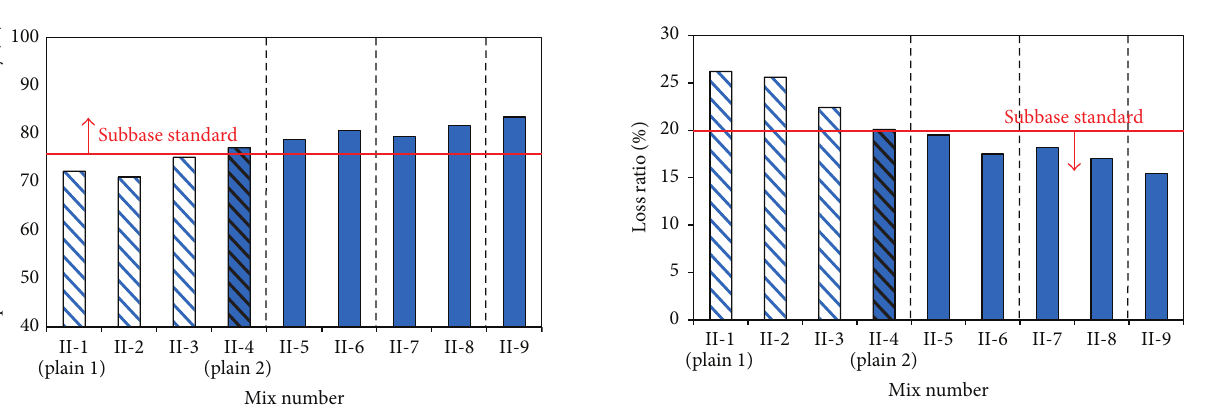
Figure 8: Liquid immersion residual stability.